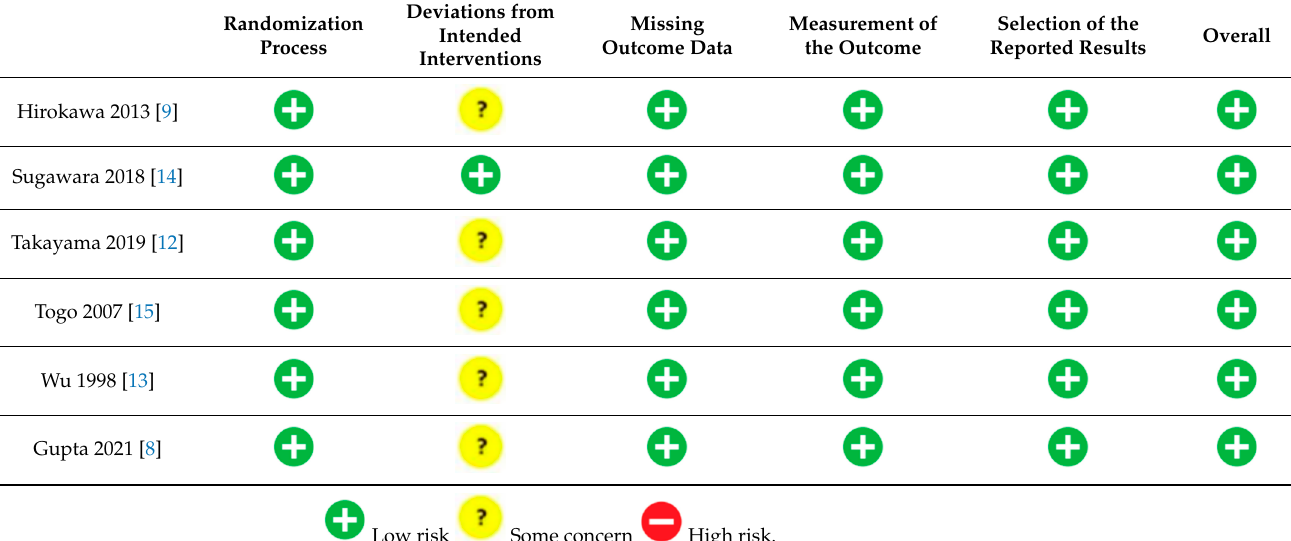
Table 3. ROBINS-I for included non-randomized comparative studies.